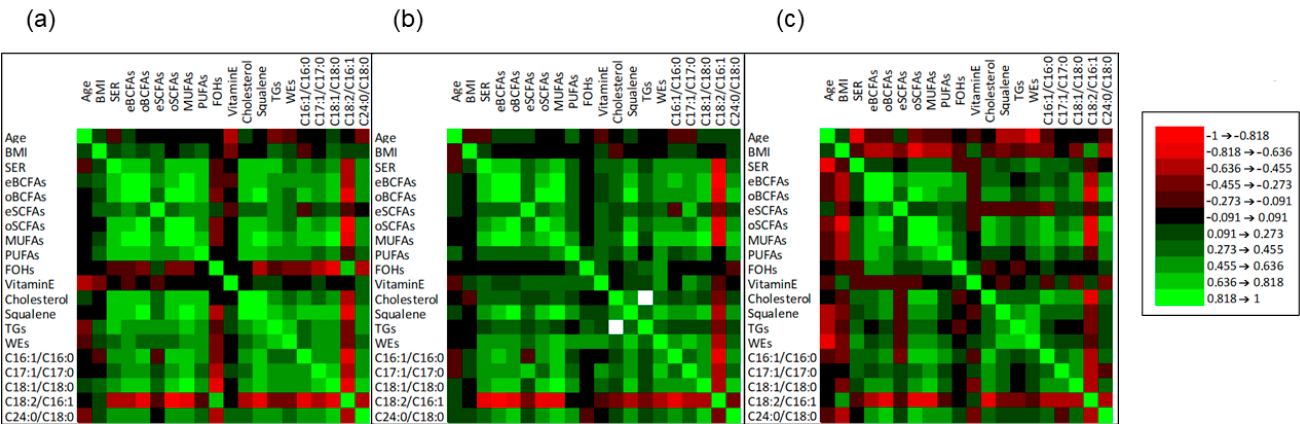
Figure 1. Matrices of Spearman’s correlation among age, BMI, SER, absolute amounts ( µ g) of grouped sebum lipids, and indexes of FA metabolism, i.e., FADS2 (C16:1/C16:0 and C17:1/C17:0 ratios), SCD1 (C18:1/C18:0 ratio), linoleate/sapienate ratio (C18:2/C16:1), and elongation (lignocerate/stearate ratio, C24:0/C18:0) in HS ( a ), AD ( b ), and PD ( c ) groups. FFAs were grouped in eBCFAs, oBCFAs, eSCFAs, oSCFAs, MUFAs, and PUFAs (see Supplementary Table S2 for the labeling). FOHs is the sum of individual FOHs. Degree of correlation and signs are depicted according to the color grade in the legend. Correlation values and significance are reported in the Supplementary Table S1. Correlation significance cut-off was set at 0.017 (Bonferroni correction).